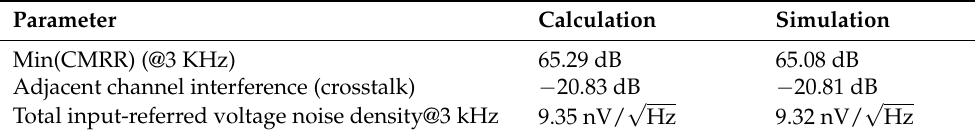
Table 8. Summary of a complete system with Type 1 interface ( R a = 10 M Ω , R cm = R d = 1 k Ω , R e = 0).